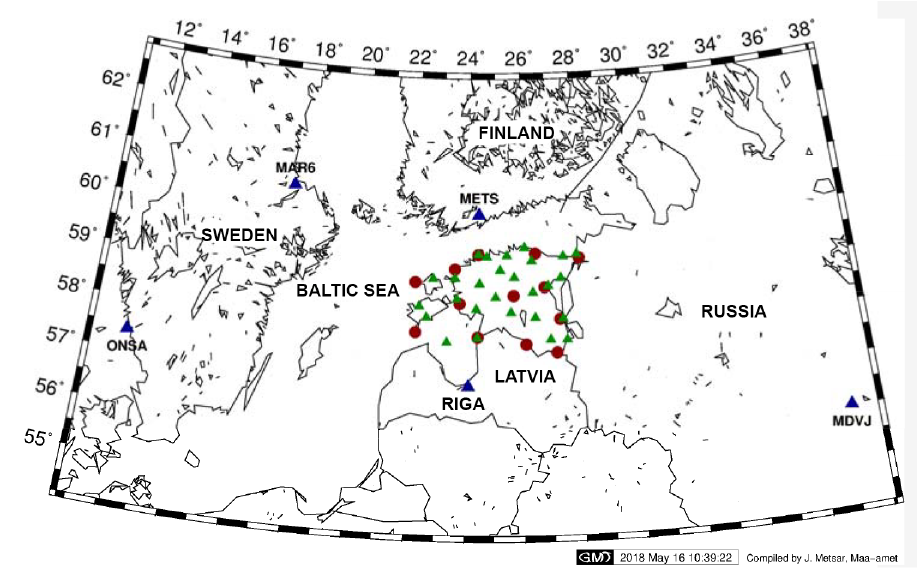
Figure 6. 2017 remeasurement campaign of Estonian I order geodetic points. Red – I order geodetic point, green – ESTPOS GNSS reference station, blue – IGS (International GNSS Service) GNSS reference station used as fix